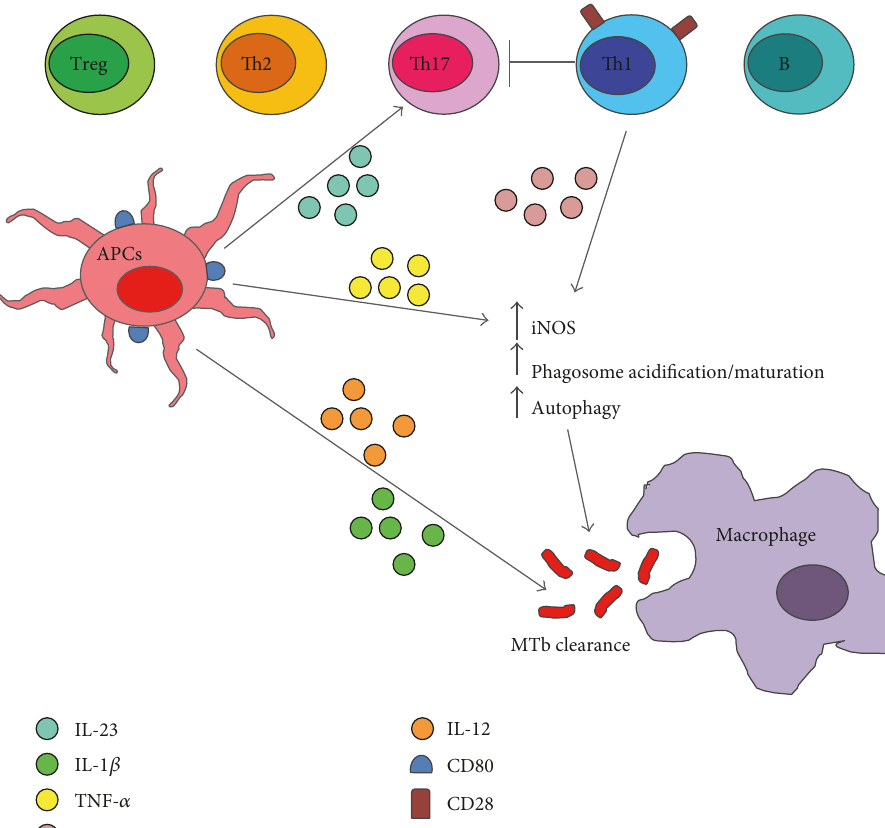
Figure 1: Schematic representation of the immune cells involved in Mycobacterium tuberculosis infection. Distinct types of T helper (Th) cells as Th1, Th2, Th17, and regulatory T cells (Treg) are present at the site of Mycobacterium tuberculosis (MTb) infection. These cells exert their functions mainly through soluble factors. In particular, Th1 cells producing IFN- γ play an essential role in MTb clearance enhancing the macrophage microbicidal mechanisms through the activation of the iNOS pathway and the induction of phagosomes acidi fi cation, maturation, and autophagy. Moreover, tumor necrosis factor- (TNF-) α , produced by antigen presenting cells (APCs) after MTb stimulation, acts synergically with IFN- γ thus contributing to MTb control. APCs produce also interleukin- (IL-) 12 and IL-1 β that are essential for resistance to MTb. Moreover, IL-23 produced by APC induces the di ff erentiation of Th17 cells producing IL-17, IL-17F, IL-6, and TNF- α . Th17 cells are associated with MTb protection; however, when Th17 cell responses became pathogenic rather than protective, Th1 cells are induced to stop these dangerous e ff ects. Finally, the role of Th2, Treg, and B-cell subsets in human disease still remains controversial and needs further